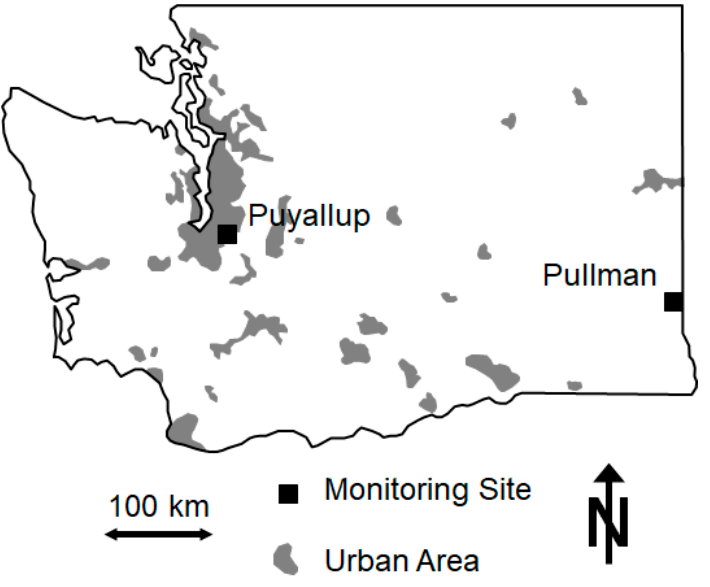
Figure 1. Site locations of deposition monitoring.